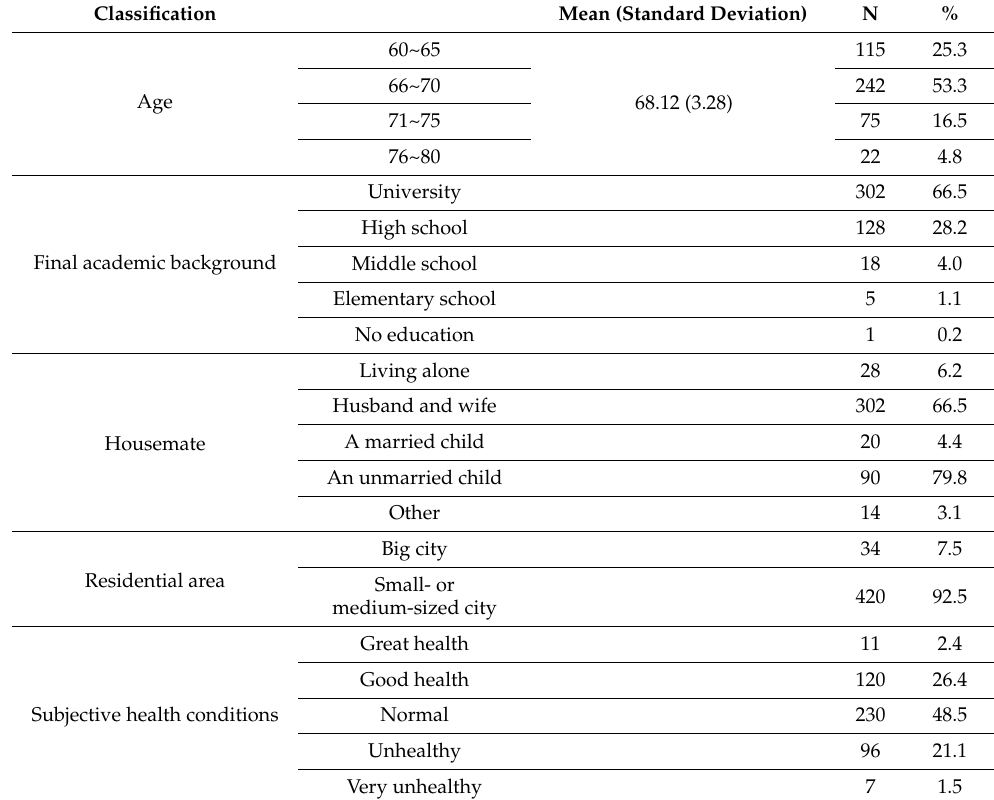
Table 3. General information of